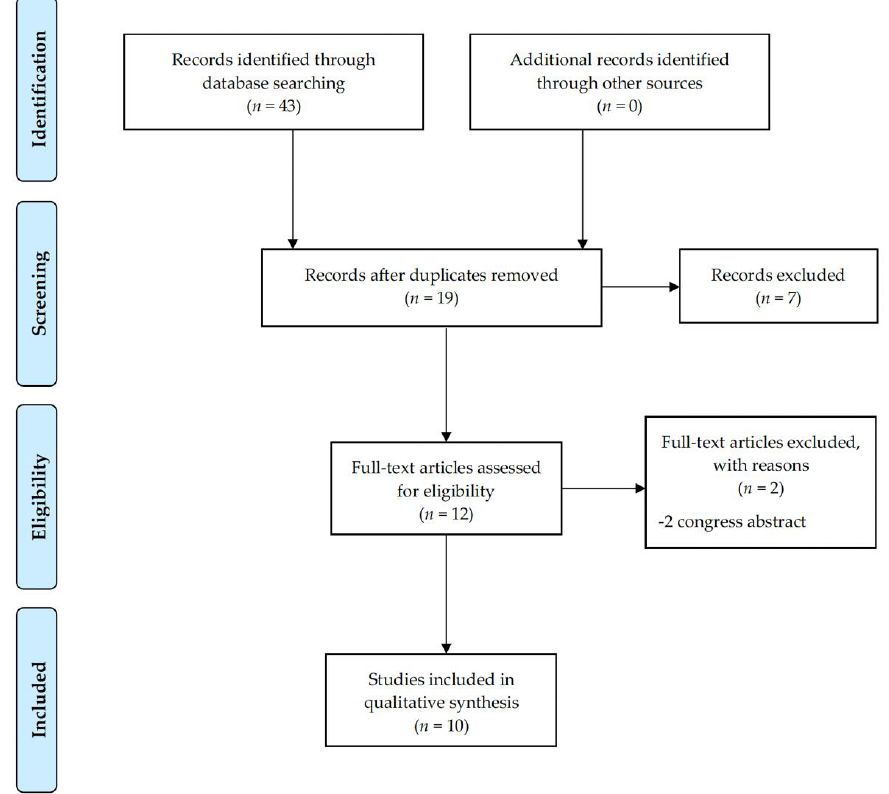
Figure 1. PRISMA flow chart from the search strategy.